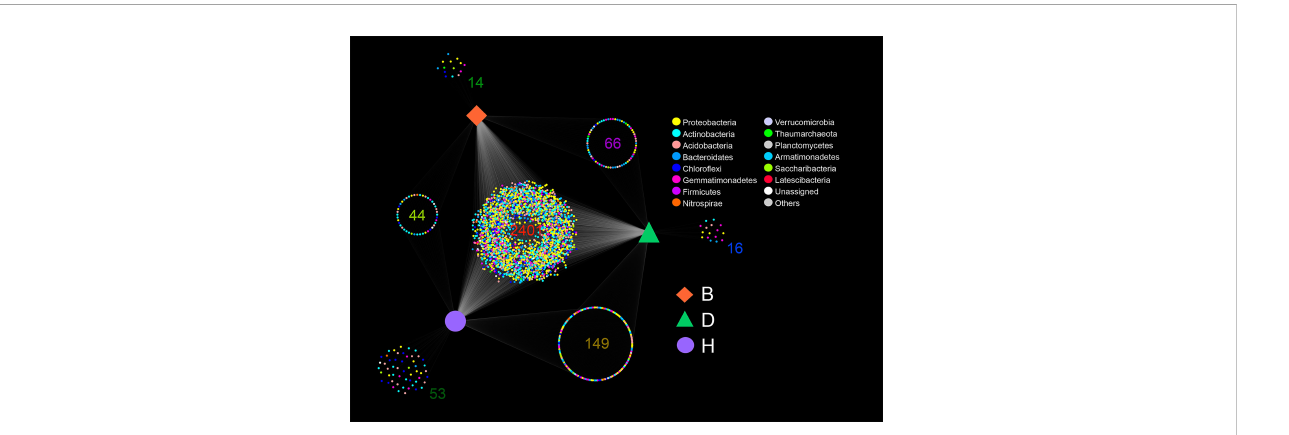
FIGURE 1 Amplicon sequence variants (ASVs) shared or monopolized by different samples. Color of the nodes representing the bacterial phyla, and orange square, green triangle and purple circle representing the three groups B (Biocontrol agent), D (Disease) and H (Healthy). The number of ASVs is provided for each